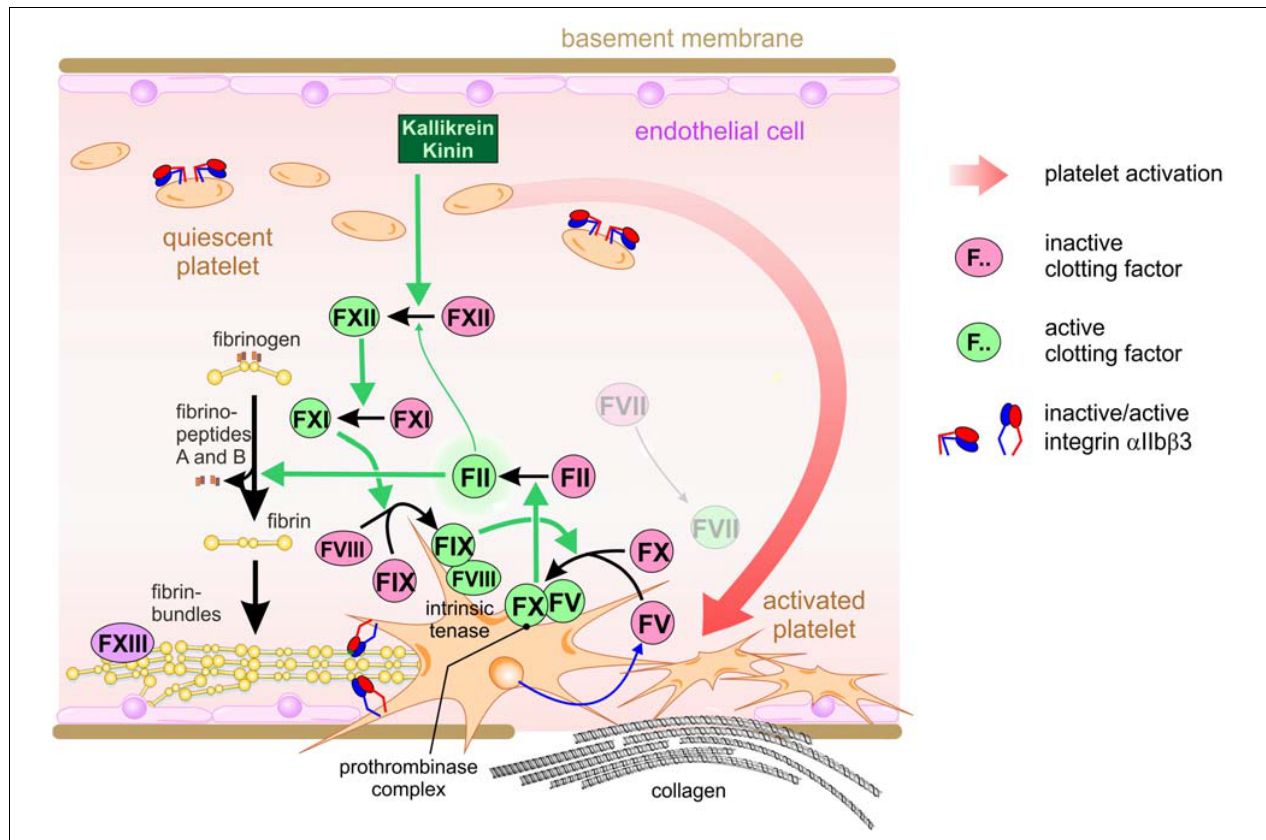
FIGURE 1 | The intrinsic coagulation pathway resulting in the hemostatic sealing of a leaky blood vessel wall. Triggered by damaged vessel walls and by exposed negatively charged surfaces, kallikrein partially cleaves and thus activates coagulation factor XII, which subsequentially activates factor XI. As the next step in this activation cascade, factor XI activates factor IX, which together with activated factor VIII associates into the intrinsic tenase complex on the surface of activated platelets which have attached to the subendothelial basement membrane or collagen fibrils at the vessel injury site. The tenase complex activates factor X, which then forms another platelet-tethered complex together with platelet-secreted factor V, the protrombinase complex. This complex turns on thrombin (factor II), resulting in fibrinogen conversion and deposition of insoluble fibrin fibrils, which are further stabilized via covalent cross-linkage by factor